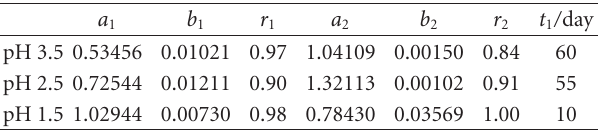
Table 3: Regression